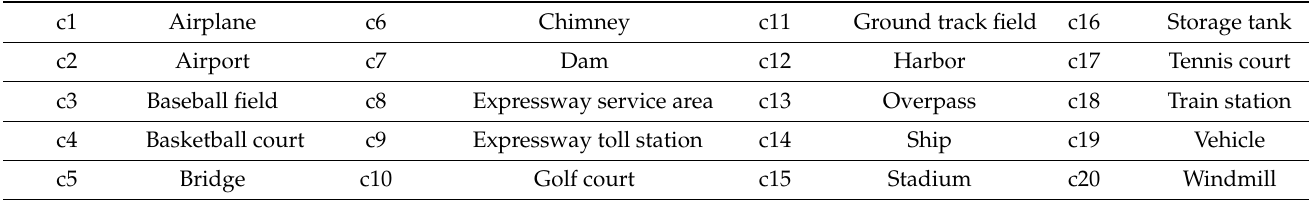
Table 3. Categories in the DIOR dataset and their corresponding